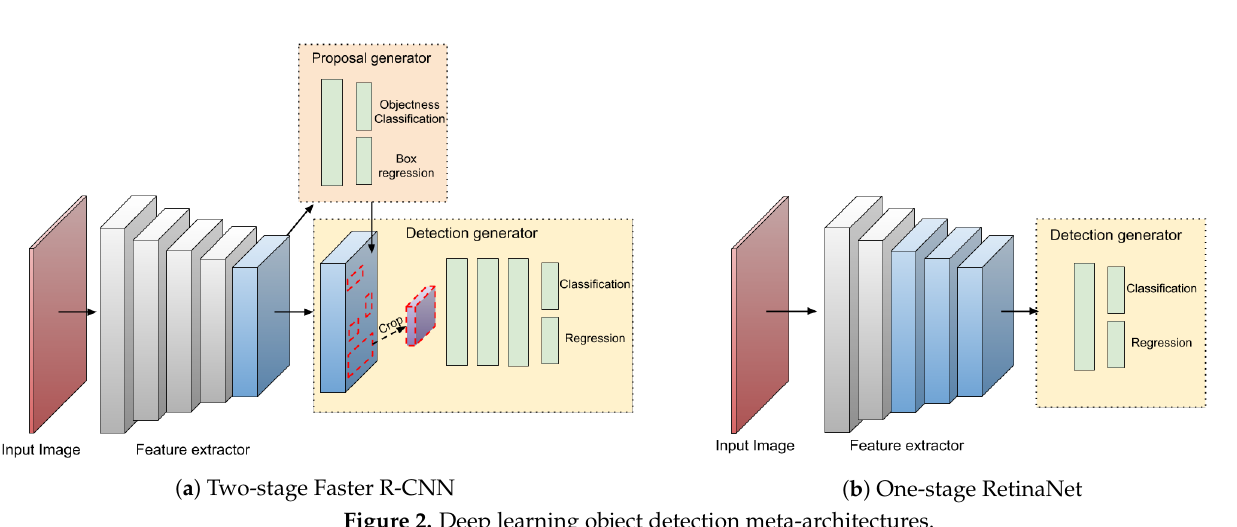
Figure 2. Deep learning object detection